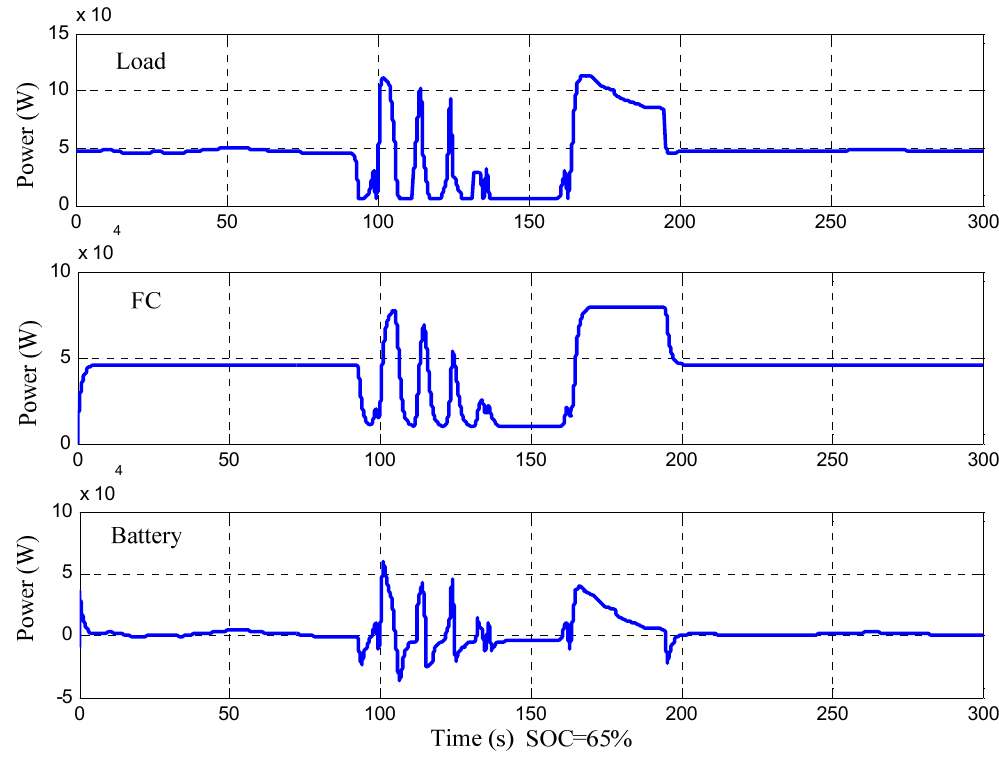
Figure 15. Power of load, FC and battery for Case 2.